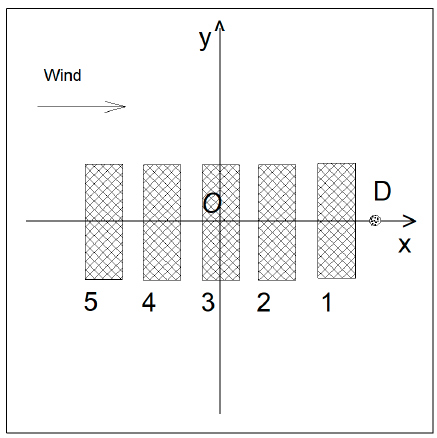
Figure 12. Layout of